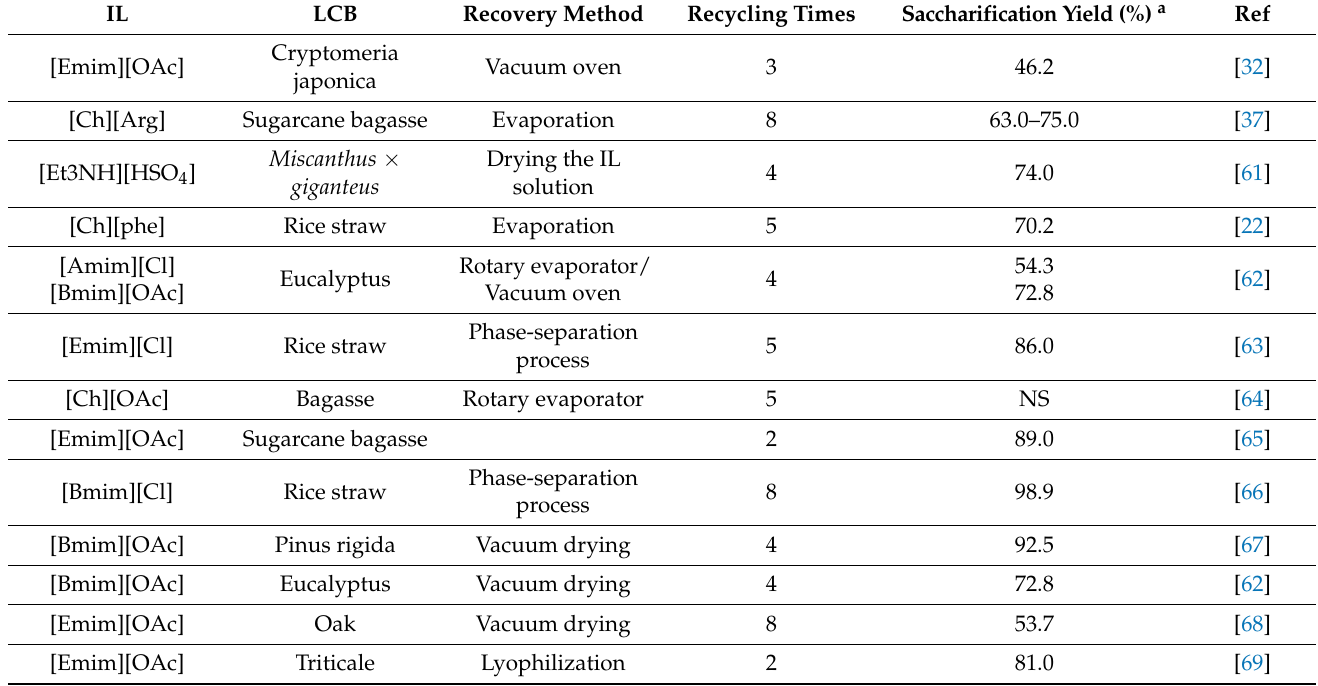
Table 2. Recovery and recycling of ILs in biomass